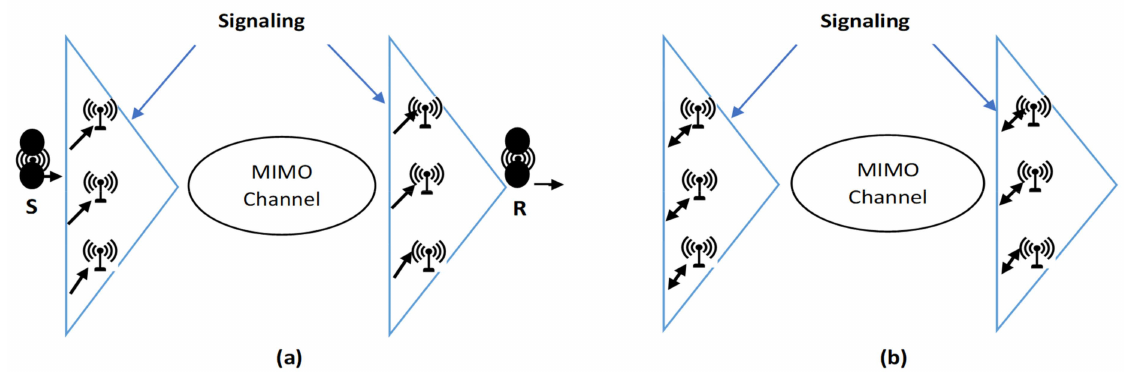
Figure 5. Distributed MIMO system possible architectures: ( a ) single source transmission and ( b ) cooperative transmission. The signaling interface, in the transmission and reception side, is assigned to establish the MIMO transmission